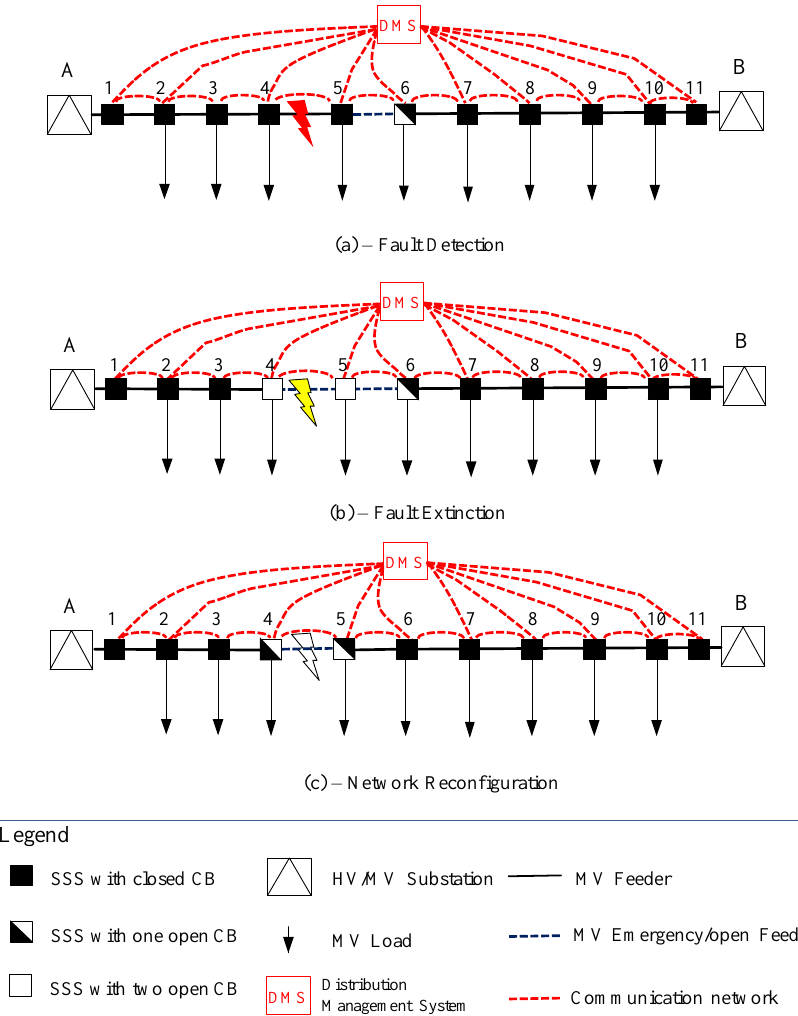
Figure 4. Radial distribution network reconfiguration managed with emergency tie.